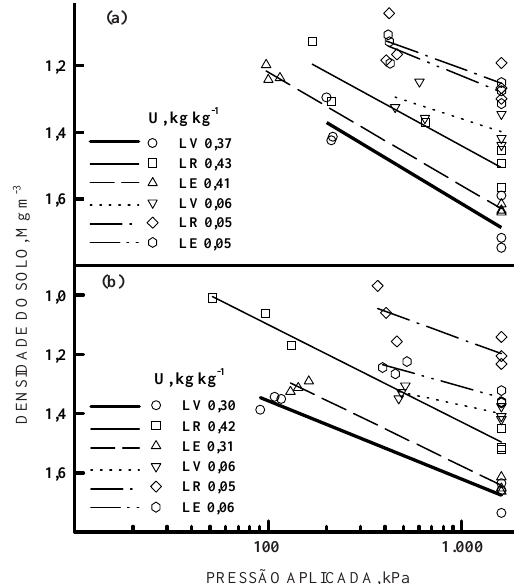
Figura 3. Retas de compressão virgem ajustadas para o Latossolo Vermelho-Amarelo (LV), Latossolo Roxo (LR) e Latossolo Vermelho- Escuro (LE) sob cultivo anual, nas profundi- dades de 0-0,03 (a) e 0,27-0,30 m (b), com a maior e a menor umidade gravimétrica (U) utilizadas (n = 6).